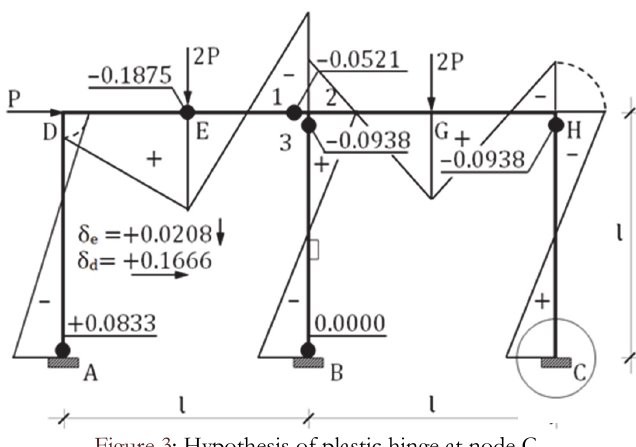
Figure 3: Hypothesis of plastic hinge at node C.